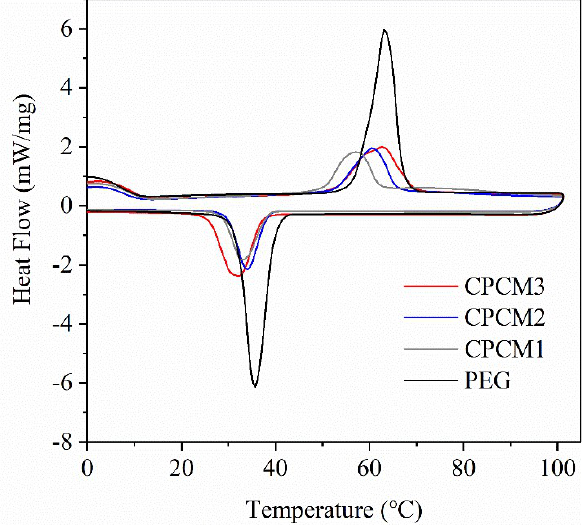
Table 2. Phase change characteristics of CPCMs and PEG.